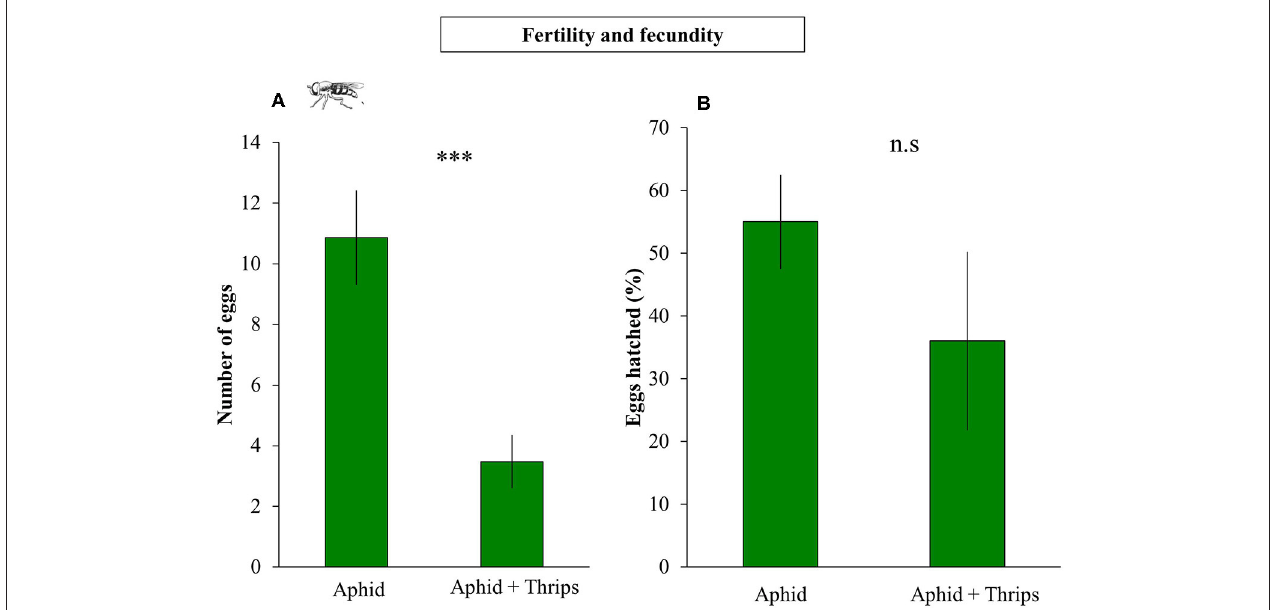
FIGURE 3 | Fecundity and fertility of S. rueppellii female adults after completing their life cicle feeding on aphid-infested plants ( n = 21 replicates) and on aphid + thrips-infested plants ( n = 17 replicates). (A) Number of syrphid’s eggs laid (Fecundity) and (B) number of viable eggs hatching (Fertility). Bars represent means ± SE. Asterisks indicate significant differences between infestation treatments: *** P < 0.001, n.s not significantly different P > 0.05 (GLM).